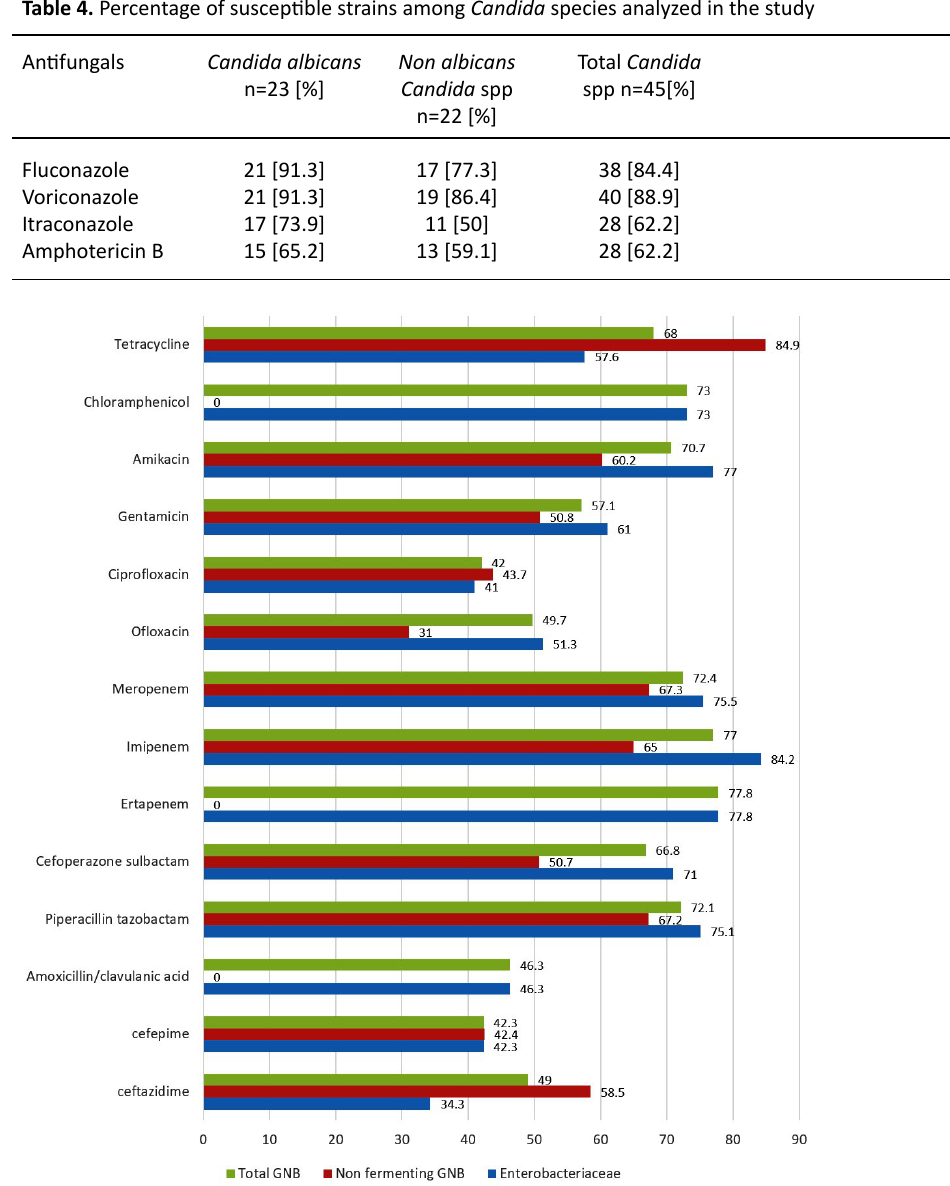
Fig. 3. Overall analysis and split analysis (Non-fermenting GNB and Enterobacteriaceae) of antibiotic susceptibility pattern of Gram-negative bacilli causing SSTI. Percentage of susceptible strains to individual antibiotics tested is